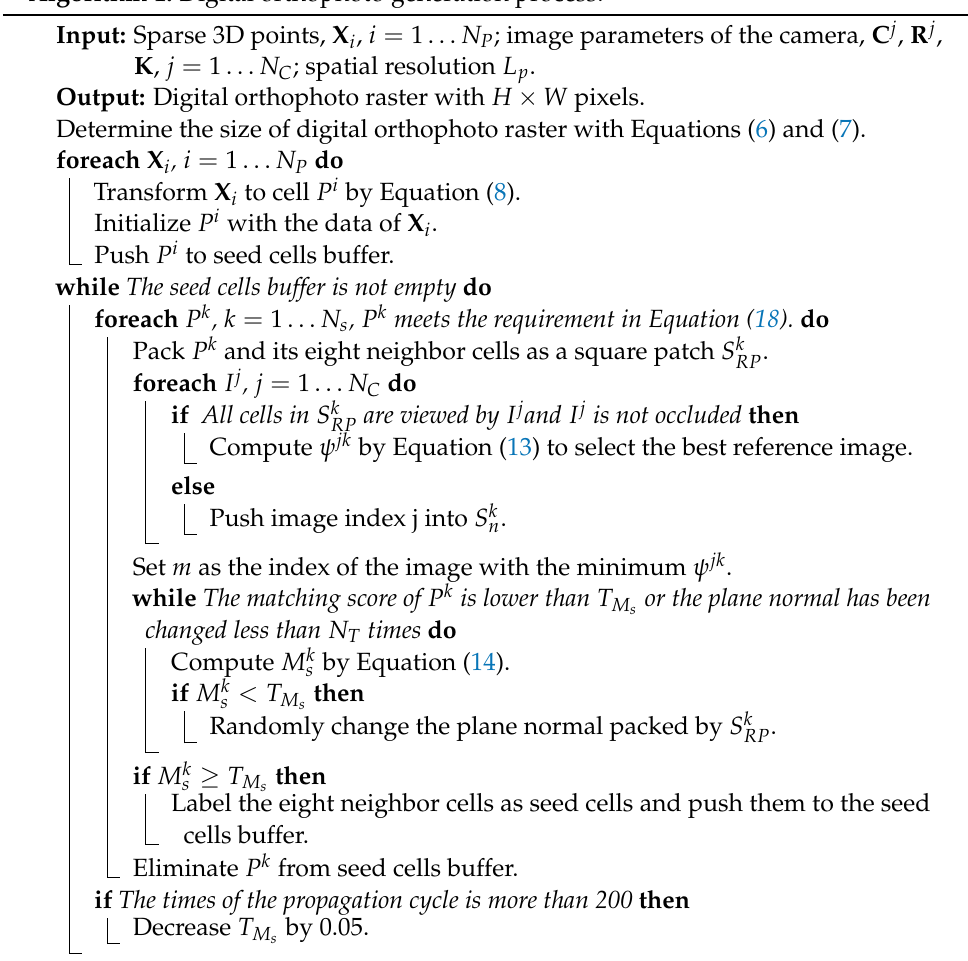
Algorithm 1: Digital orthophoto generation